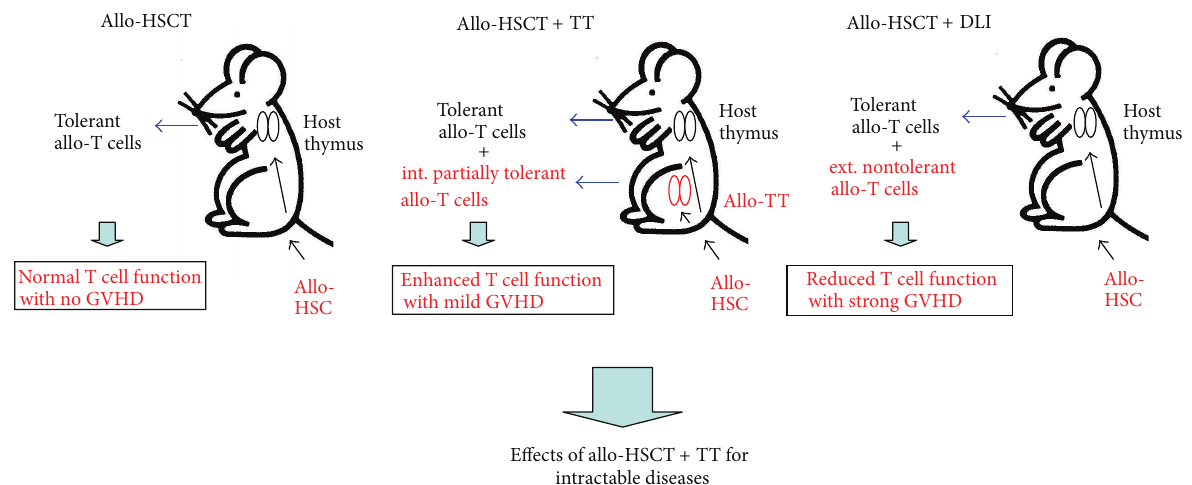
Figure 1: Theory of allo-HSCT + TT. In the case of conventional allo-HSCT (left), the allo-T cells develop and are tolerated in the host thymus, and no GVHD occurs. In the case of allo-HSCT + DLI (right), nontolerated allo-T cells are externally supplied, and strong GVHD is induced with reduction of T cell function. In the case of allo-HSCT + TT, the allo-T cells develop internally in the allothymus. The T cells show partial tolerance to the host, and only mild GVHD occurs with elevation of T cell function (middle).